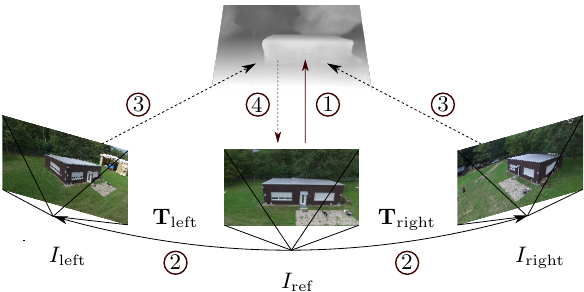
Figure 2. Training procedure with the estimation of depth (1) and pose (2) information, as well as the sampling of the synthetic images (3) and the calculation of the reconstruction error